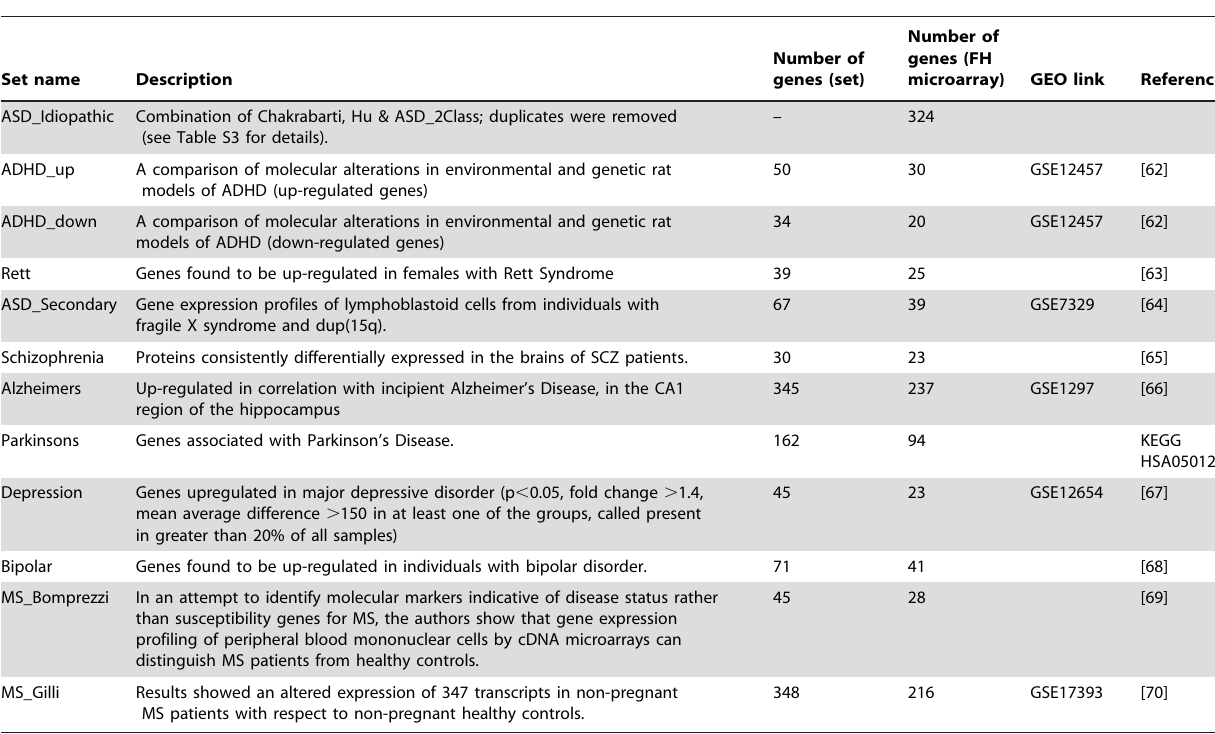
Table 2. ‘‘ND’’: Sets of genes associated with various human neurological